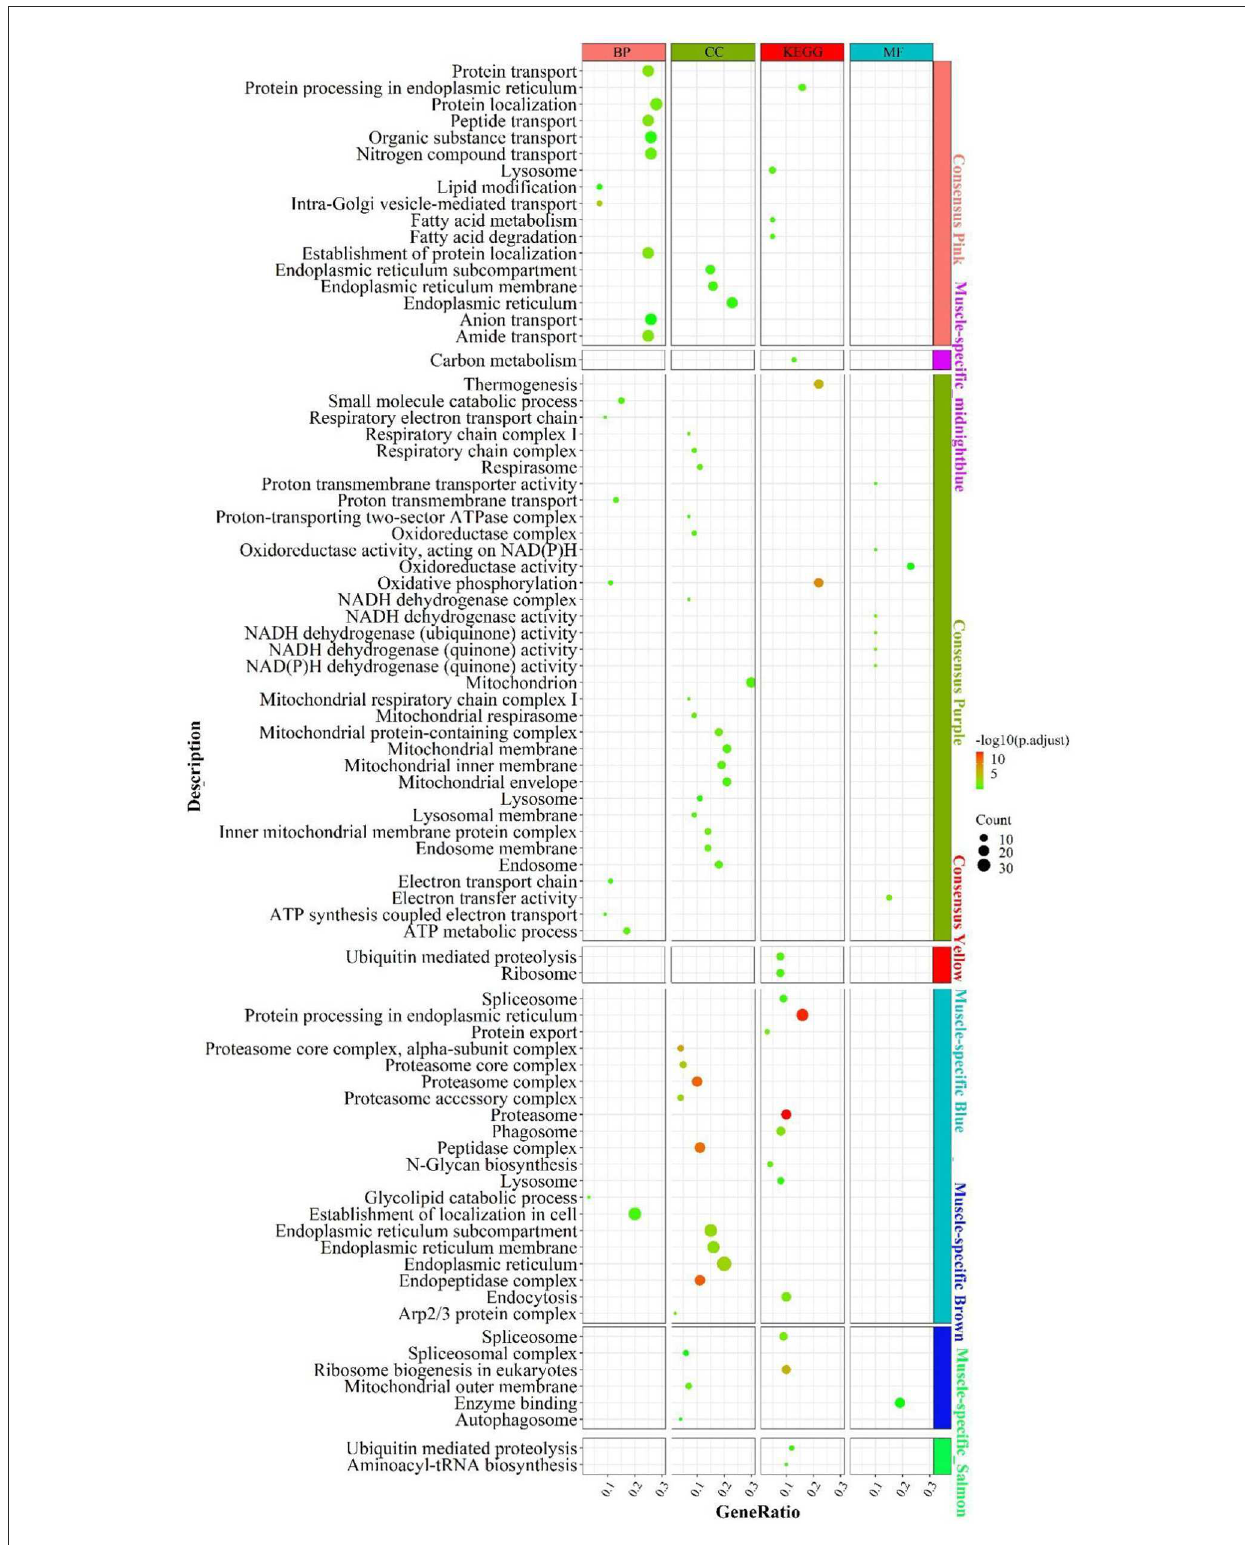
FIGURE4 Enrichment analysis for consensus or liver-/muscle-specific modules in LM regulatory axis. The dot size and color represented enriched gene numbers and the enriched significance.